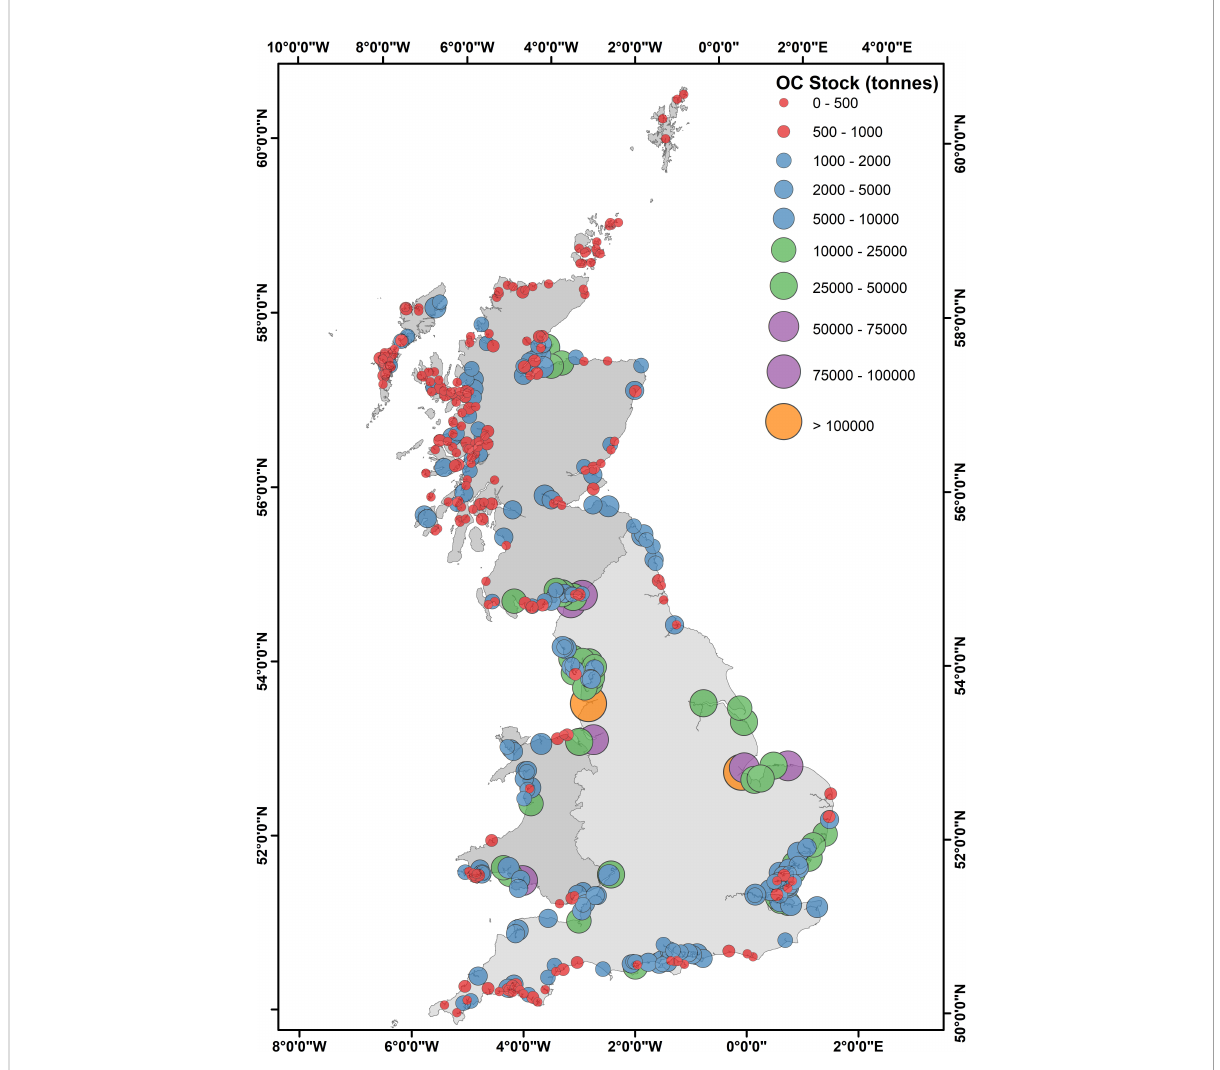
FIGURE 8 Mapped sur fi cial soil OC stocks (tonnes) for individual saltmarshes across Great Britain. Size of circle represent the absolute magnitude of the stock (tonnes) while the colors highlight ranges: Red: < 1,000 tonnes OC, Blue 1,000 – 10,000 tonnes OC, Green: 10,000 – 50,000 tonnes OC, Purple: 50,000 – 100,000 and Orange > 100,000 tonnes OC. Full breakdown of OC stocks can be found in the supplementary